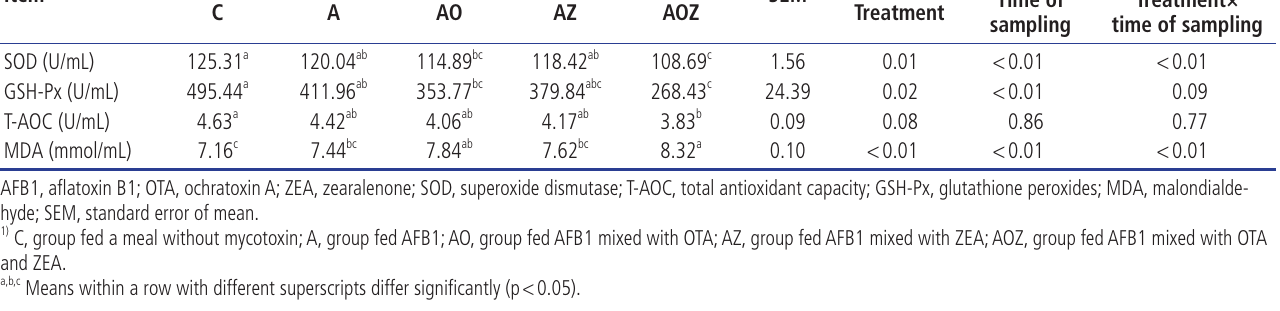
Table 6. Effects of AFB1, OTA, and ZEA on SOD, T-AOC, GSH-Px activities and MDA concentrations in dairy goats